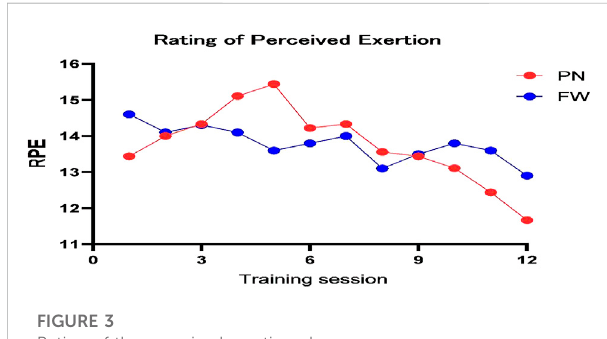
FIGURE 3 Rating of the perceived exertion change